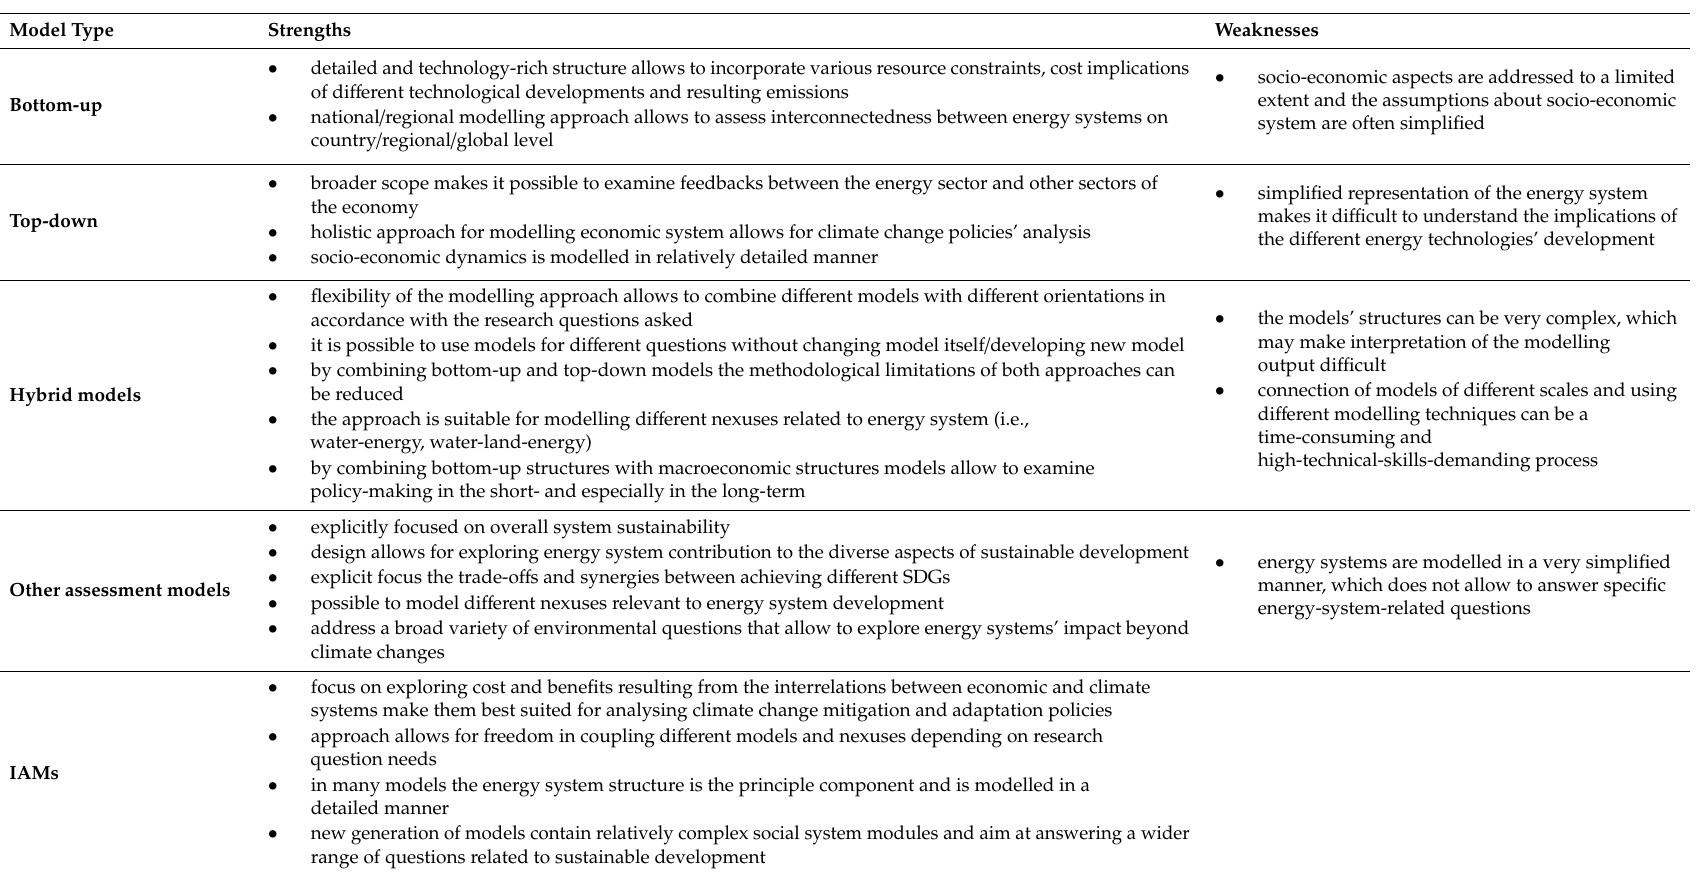
Table 3. Strengths and weaknesses of di ff erent model